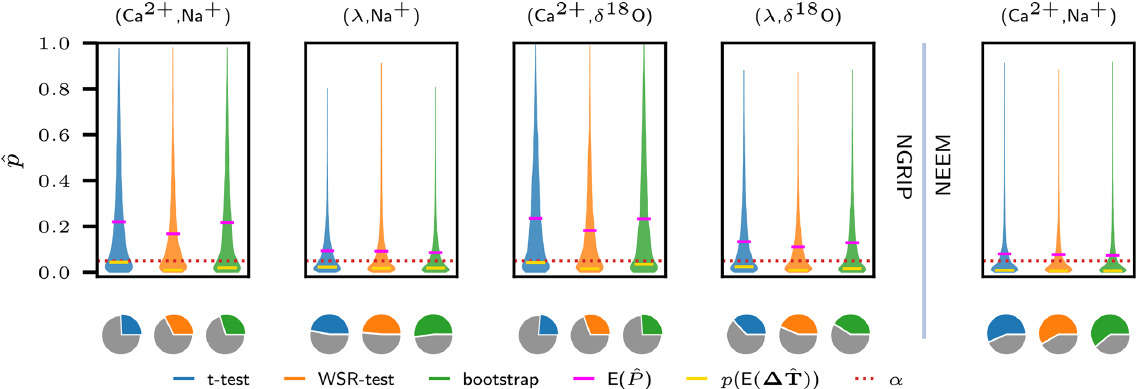
p,q . The violin plots show the Gaussian i